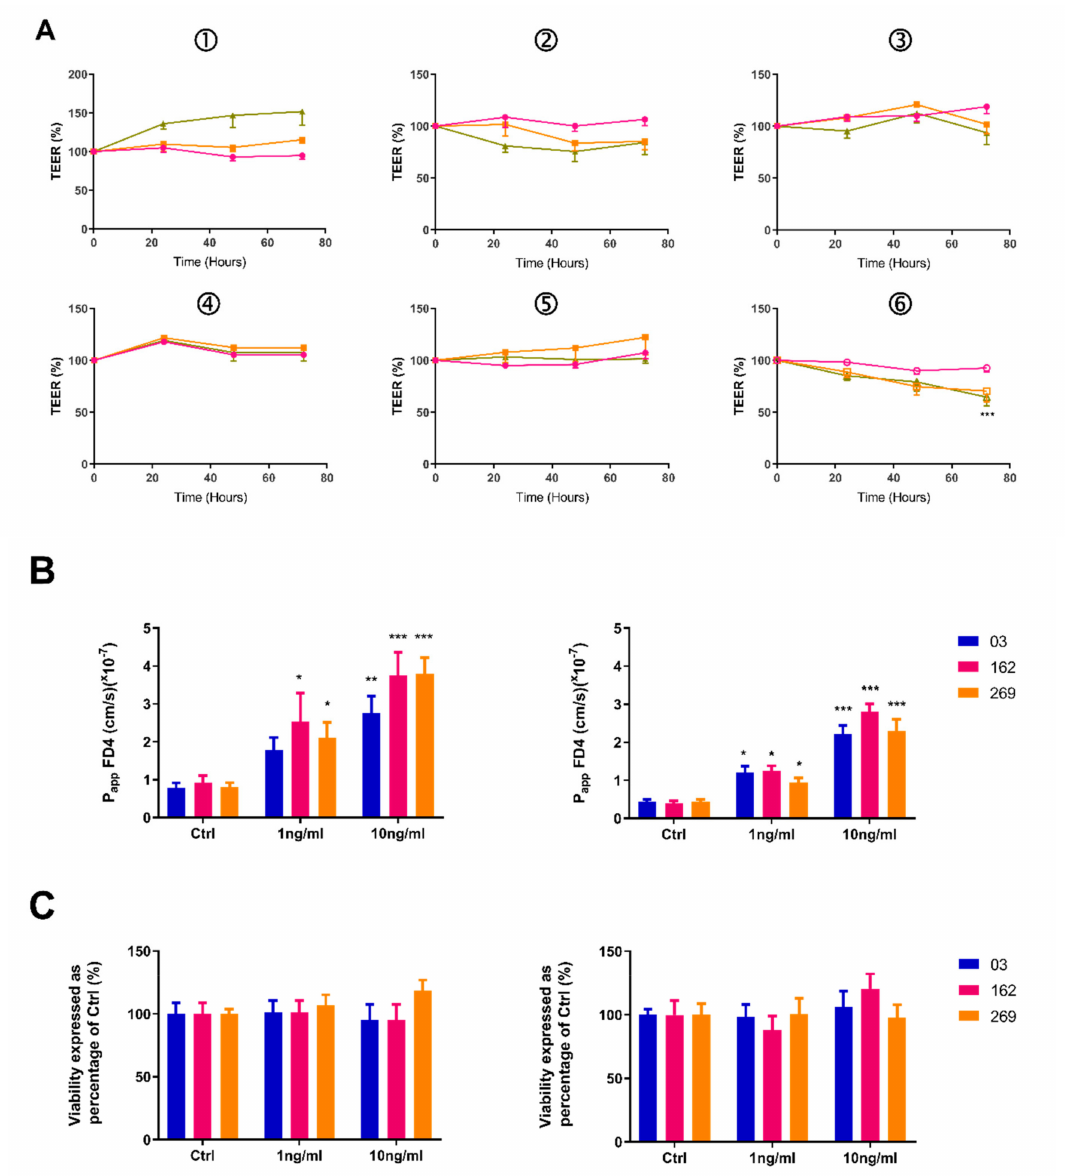
Figure 3. E ff ect of basolateral side addition of both TNF α and IFN γ (1 and 10 ng / mL) for 72 h on ( A ) % TEER values measured across HIO (1, 2, 3) and HCO (4, 5, 6) epithelium grown on Transwell inserts. ( B ) P app of apically-added FD4 across HIO- / and HCO-derived epithelium obtained over 120 min. ( C ) MTS viability indicated no cytotoxic e ff ect from exposure to TNF α and IFN γ . Two-way ANOVA with Bonferroni’s multiple comparisons; * p < 0.05, ** p < 0.01, *** p < 0.001 compared with respective control. Each value represents the mean ± SEM, n = 3, with 3 independent